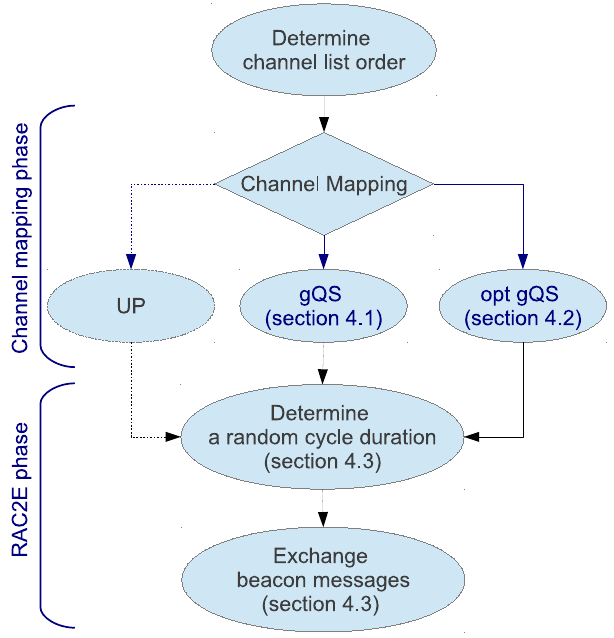
Figure 2. Asynchronous rendezvous-MAC protocol diagram with a choice of three different mapping methods, namely, UP, gQS, and optimized